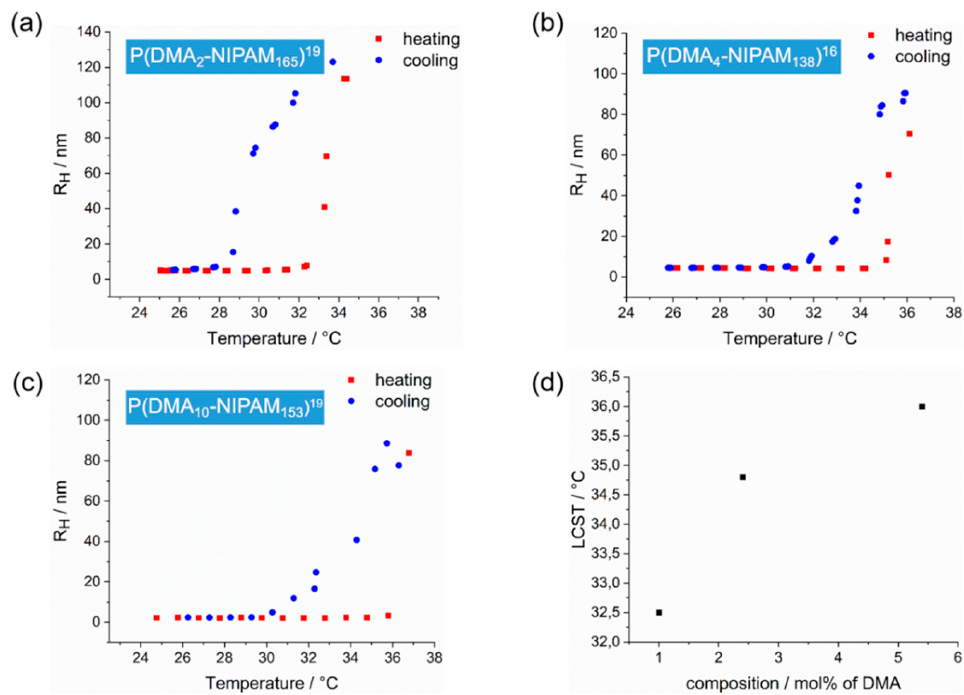
Figure 7. Temperature-dependent evolution of the hydrodynamic radii of three P(DMA- co -NIPAM) copolymers with different copolymer compositions in aqueous solution (c = 1% ( w / w )) obtained by DLS. The red dots show the evolution of the hydrodynamic radii during the heating step of the polymer solution. In contrast, the blue dots represent the development of the corresponding radii during the cooling step. Hydrodynamic radii evolution of ( a ) P(DMA 2 -NIPAM 165 ) 19 , ( b ) P(DMA 4 - NIPAM 138 ) 16 , and ( c ) P(DMA 10 -NIPAM 153 ) 19 . ( d ) LCST versus copolymer composition. The LCST increases with the increasing molar fraction of DMA.